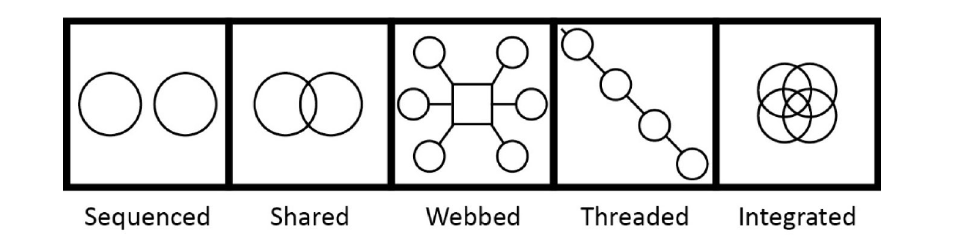
Figure 1: Five types of curriculum integration across several disciplines (Fogarty,